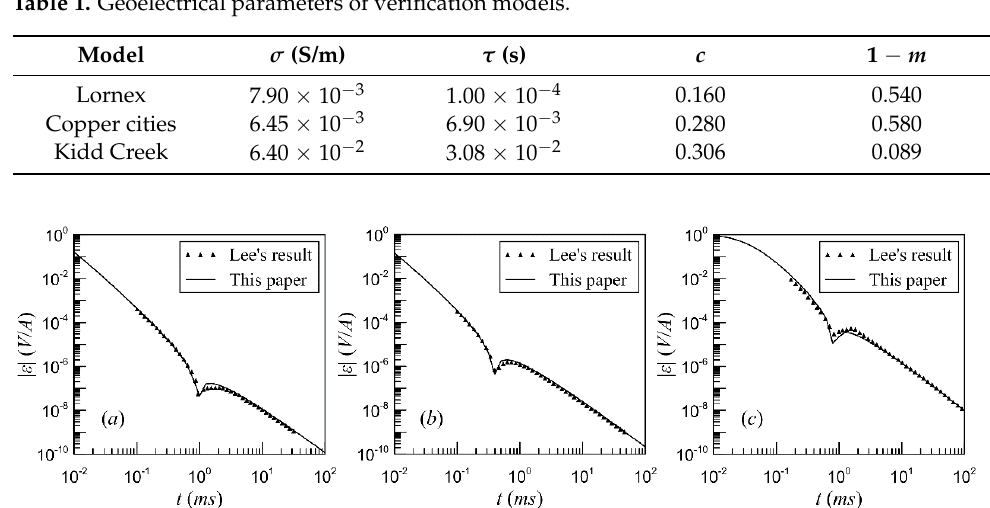
Figure 2. Validation of the modeling results. ( a ) The Lornex model; ( b ) The Copper cities model; ( c ) The Kidd Creek